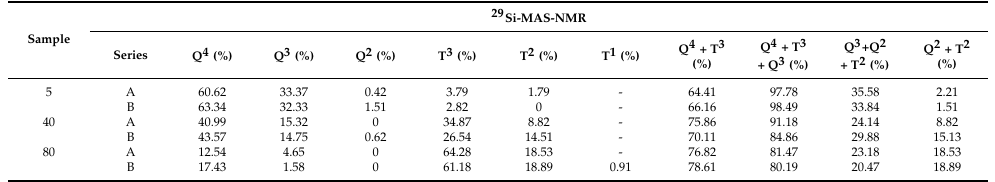
Table 1. Comparison of the number of species determined from the 29 Si-MAS NMR spectra for series A and B (series A and series B labels represent the pH = 2.0 and pH = 4.5).